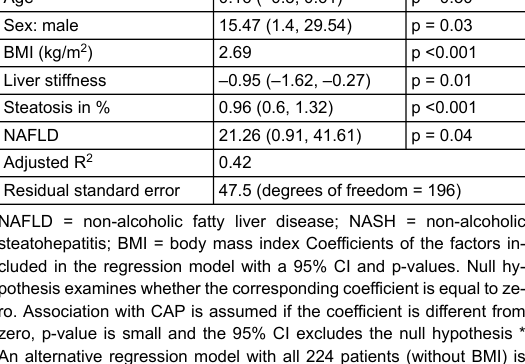
Table 4: Multivariate analysis, regression model including the 203 pa- tients with body mass index (BMI) data available. * Intercept